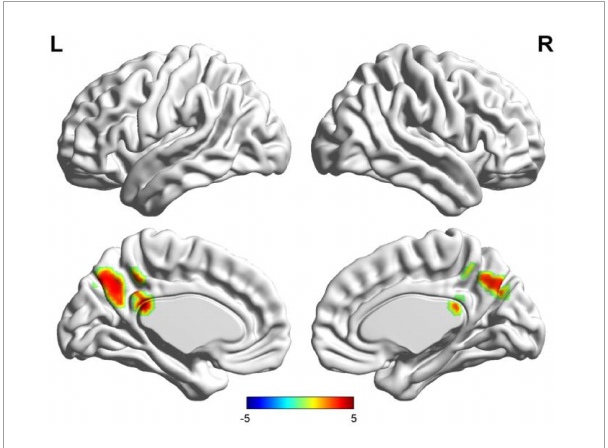
FIGURE3 Results of two-sample t -test of functional connectivity of Wernicke’s region (the seafarer group > the non-seafarer group; p 0.005, cluster size > 200 voxels, corresponding to corrected p FWE 0.05). R: right hemisphere, L: left